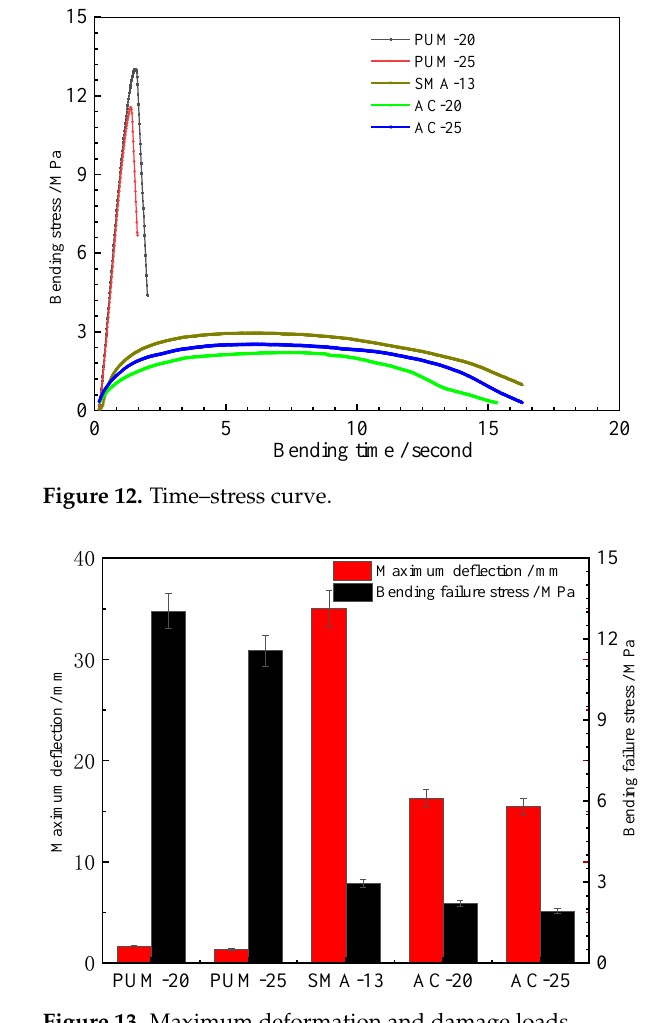
Figure 12. The maximum deformation and bending failure stress are shown in Figure 13.